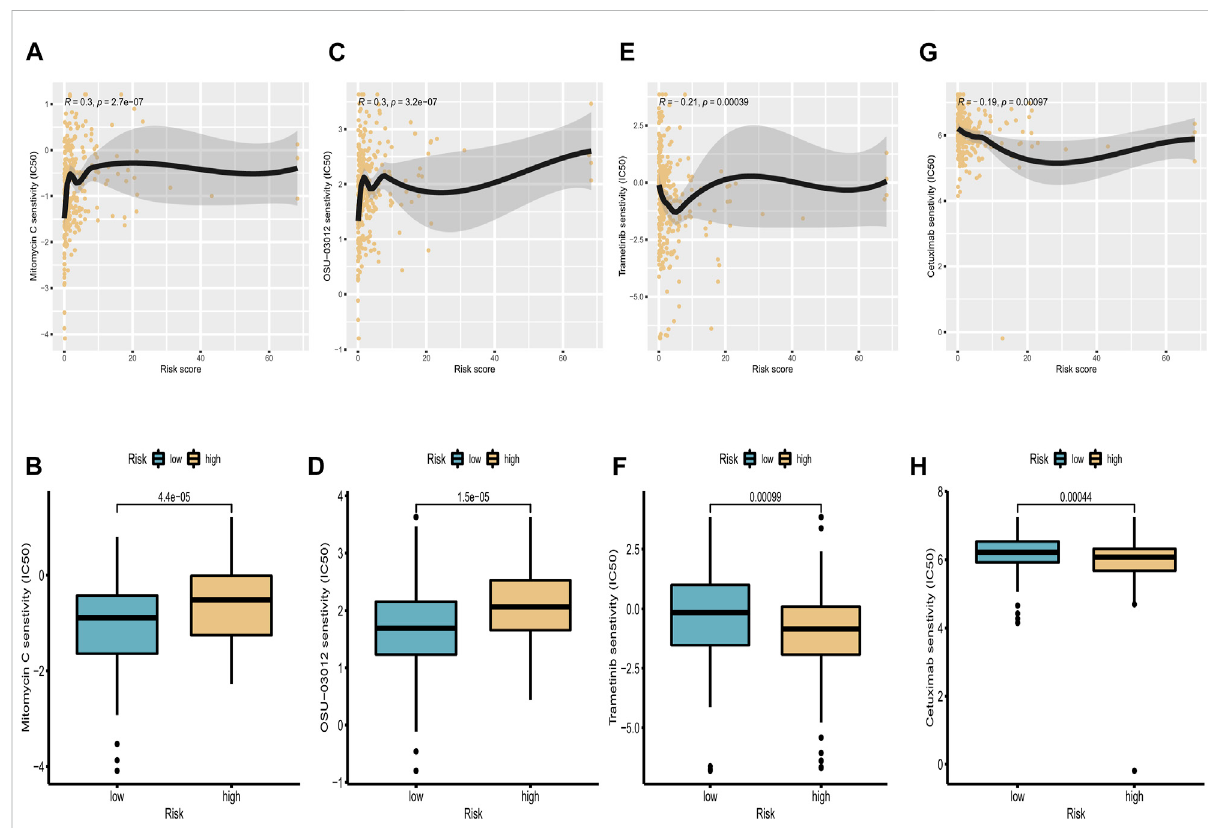
FIGURE 9 Correlation analysis of targeted drugs. (A,C,E,G) Correlations between IC50 levels of four targeted drugs (osu-03012, mitomycin C, trametinib, and cetuximab) and expression of cuproptosis-related lncRNAs. (B,D,F,H) Differences in sensitivity to osu-03012, mitomycin C, trametinib, and cetuximab between high-risk and low-risk